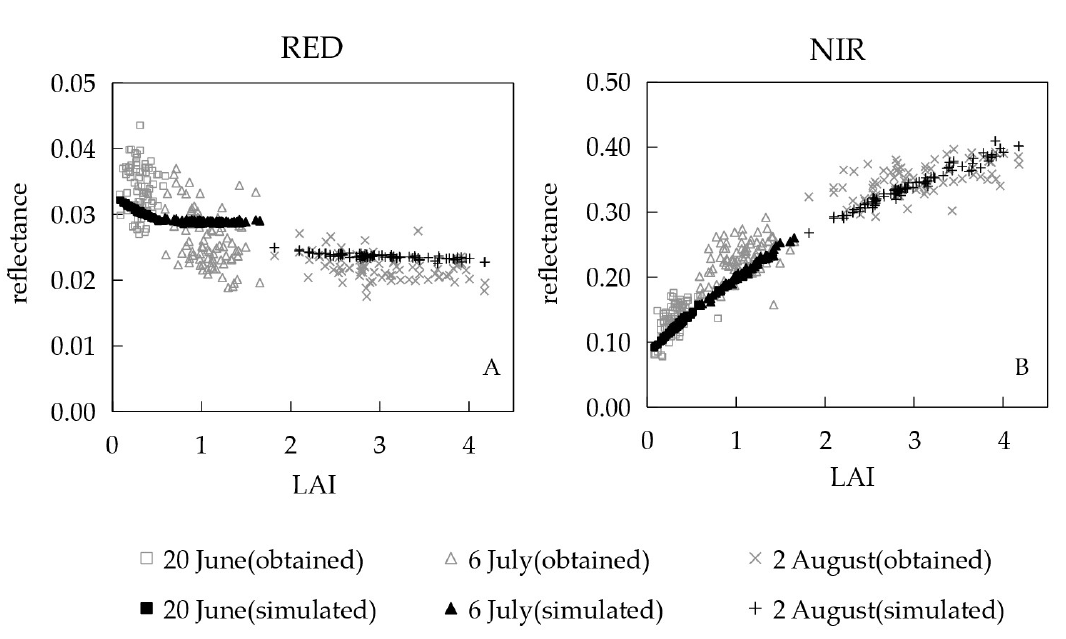
Figure 4. Comparison of the canopy reflectance for RED (A) and NIR (B) obtained from the reflectance image made from the aerial multispectral images collected by UAV in paddy fields on 20 June, 6 July, and 2 August in 2017 and the reflectance simulated by FLiES based on the parameters obtained in the field measurements. The canopy reflectance was the average of pixel values of the reflectance image in a circle with a diameter of 3 m, where the center was the measurement